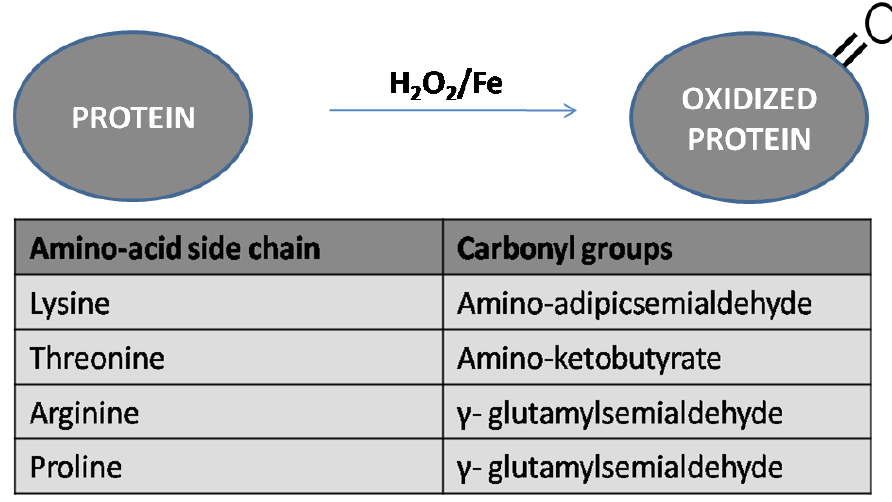
Figure 3: Protein oxidation and formation of carbonyl groups ( aldehydes or ketones) from side chain